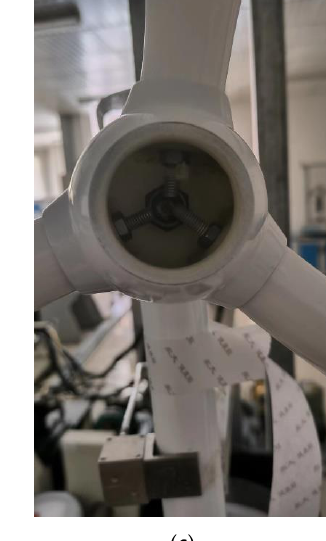
Table 1. Parameters of the acceleration sensor.